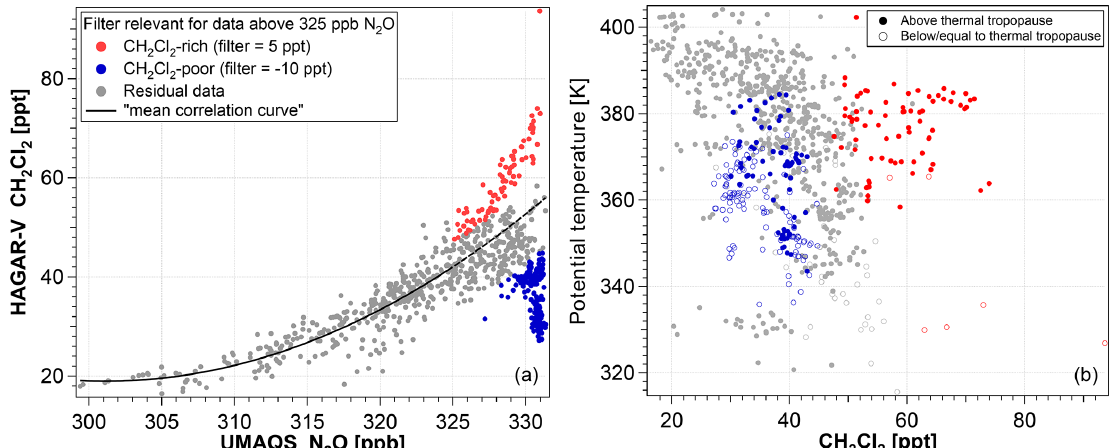
Figure 5. (a) CH 2 Cl 2 –N 2 O relationship color coded with the definition of the data filter used. Red data points are measurements considered CH 2 Cl 2 -rich air with mixing ratios more than 5ppt higher than the mean correlation curve and N 2 O ≥ 325ppb. Blue data points are mea- surements considered CH 2 Cl 2 -poor air with mixing ratios more than 10ppt lower than the mean correlation curve and N 2 O ≥ 325ppb. The mean correlation curve is derived from a quadratic fit to the CH 2 Cl 2 –N 2 O relationship for N 2 O < 325ppb extrapolated to higher mixing ratios relevant for the data filter (dashed line). (b) Scatterplot of CH 2 Cl 2 as a function of the potential temperature, color coded to high- light CH 2 Cl 2 -rich (red) and CH 2 Cl 2 -poor (blue) air. On average the CH 2 Cl 2 -rich air is found at higher potential temperatures than the CH 2 Cl 2 -poor